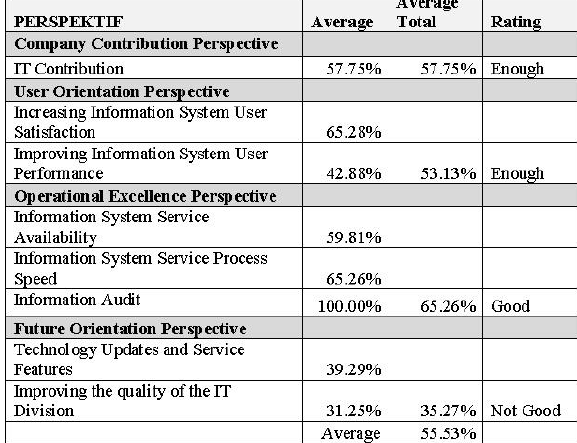
Figure 10: Strategic Size and Strategic Objectives of the IT Balaced